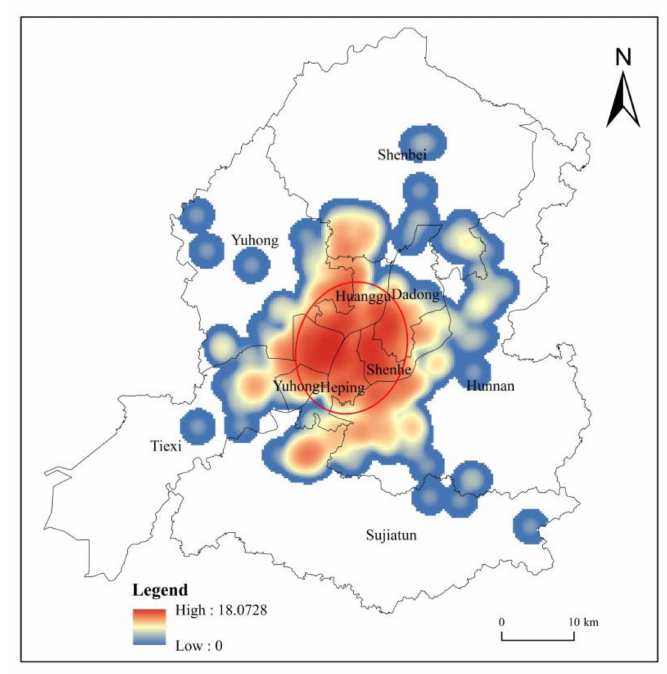
Figure 4. Overall residential communities distribution in